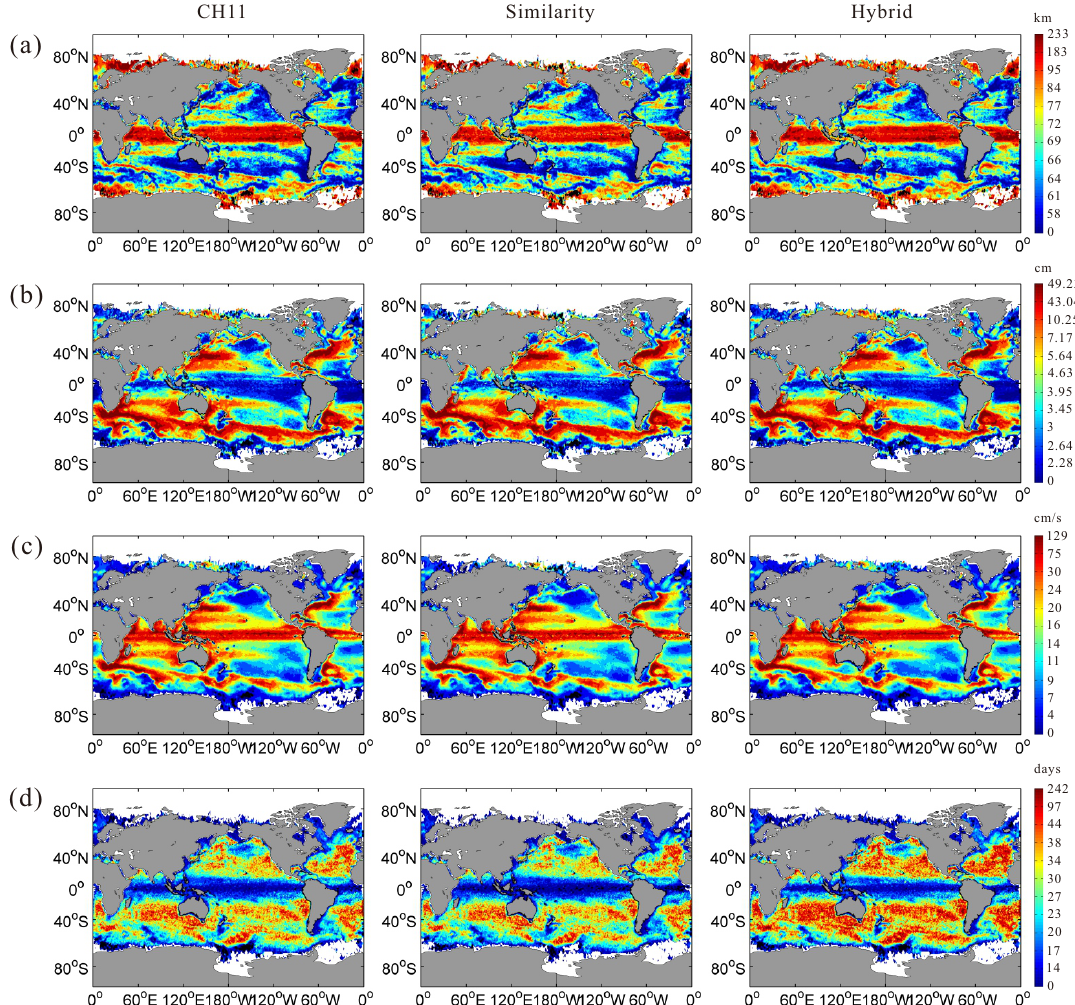
Figure 10. Average eddy properties, including the ( a ) radius (km); ( b ) amplitude (cm); ( c ) rotational speed (cm/s) and ( d ) lifespan (days), for eddies with lifespans longer than 10 days for each 1 ◦ × 1 ◦ region from(from left to right) the CH11, similarity and hybrid